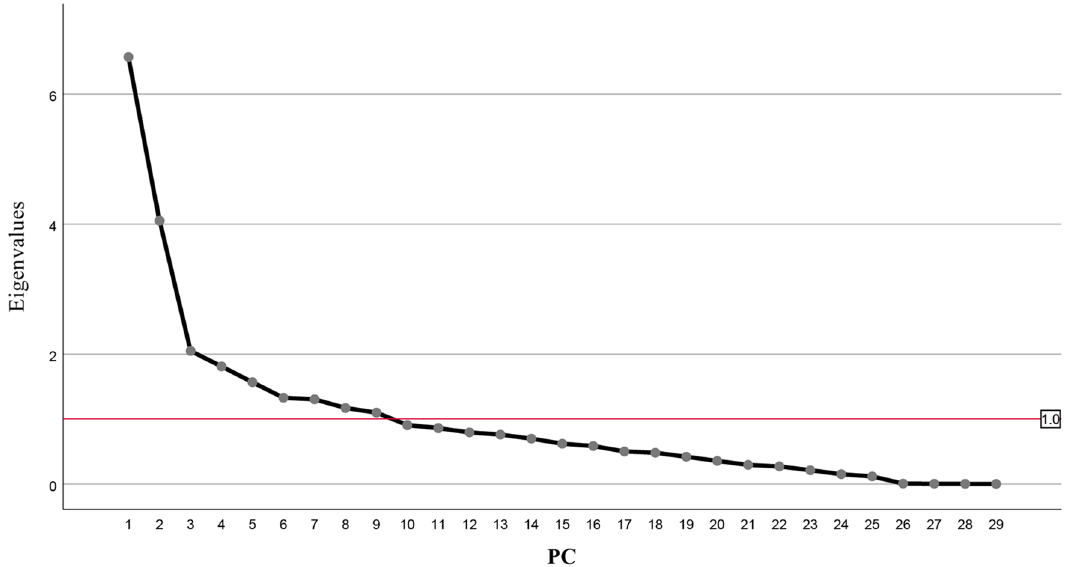
Figure 4. The principle component analysis showed eigenvalues of the first 9 principal components were greater than 1. The first 9 principal components had the cumulative contribution rate reach 72.20%, indicating the first 9 principal components represent most of the trait information from the phenotypic traits of Calamansi (figure is generated by SPSS software, Version SPSS 25.0, https:// www. ibm. com/ suppo rt/ pages/ node/